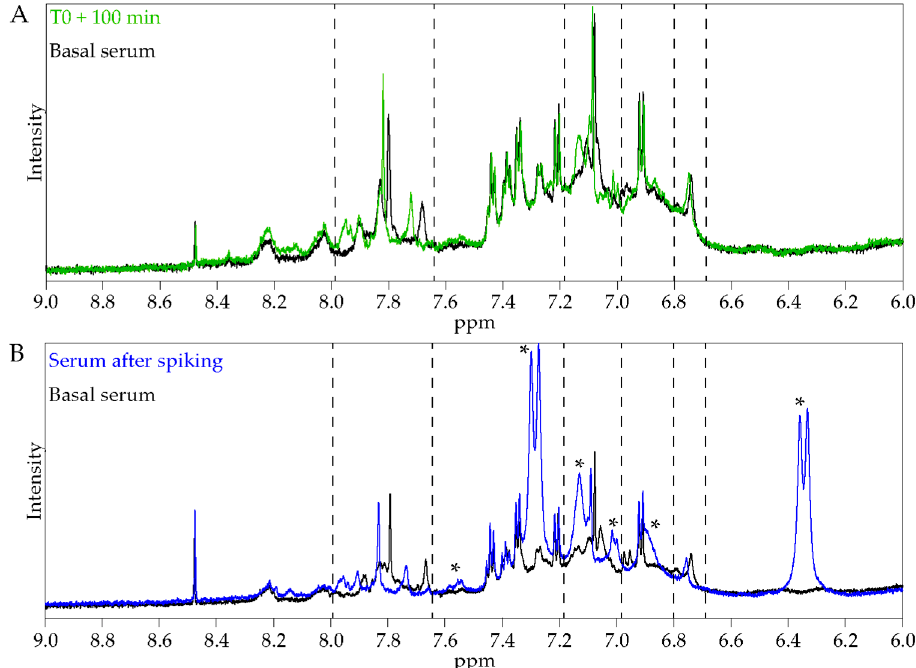
Figure 3. Expansion of the phenolic region of 1 H NMR spectra of serum. ( A ) Expansion of the phenolic region of 1 H NMR spectra of serum collected at T0 (black) and T0+100 min (green). ( B ) Expansion of the phenolic region of 1 H NMR spectra of a basal serum (black) and after spiking with caffeic and quinic acids (blue). *: caffeic acid signals.